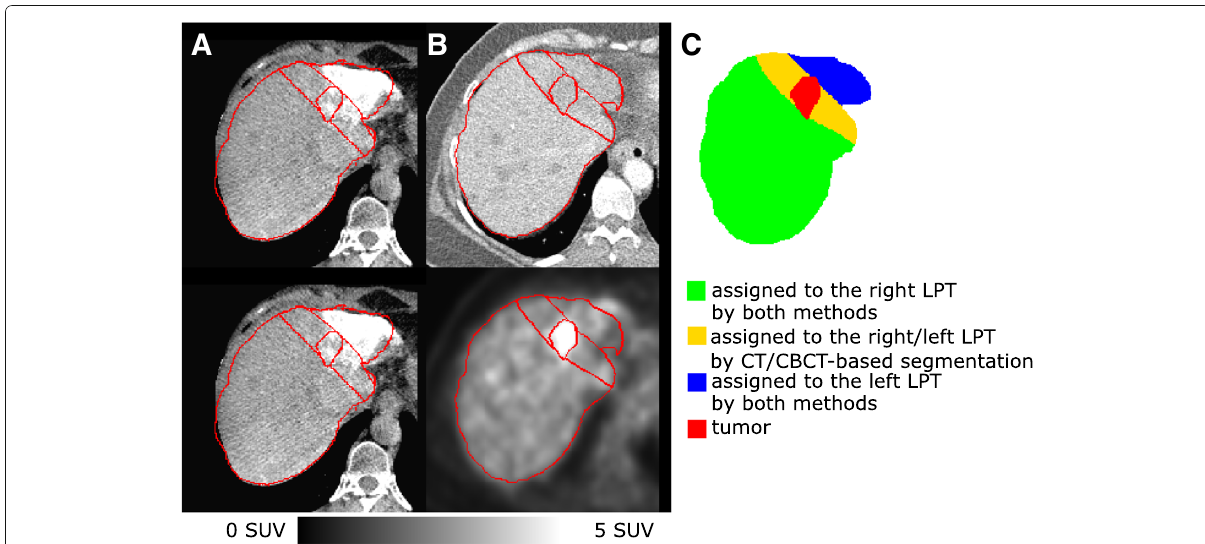
Fig. 13 An example (patient ID BI02 from training set in our database) of a transaxial view of early and late CBCTs, b the 18 F-FDG PET/CT images, as well as, c CBCT/CT-based LPT segmentation and tumor segmentation (from 18 F-FDG PET). In this slice, the tumor was segmented in different lobes by the two methods. Comparing the CBCT- and CT-based lobe segmentation for this patient showed that 10% of the liver volume was assigned to different lobes (Vdiff), the ratio of “right lobe to entire liver volume ratio” for these two methods (Rratio) was 1.08 and the same parameter for the left lobe (Lratio) was 0.82. Furthermore, the average and maximum distance between lobe separation planes by these two methods (aHD and mHD) were 2.74 and 16.94 mm. Dosimetry simulation showed that a mean absorbed dose to the left and right lobe when using CBCT-based lobe segmentation were 19 and 46 Gy respectively, when we aimed at delivering 40 Gy to each lobe using the CT-based LPT